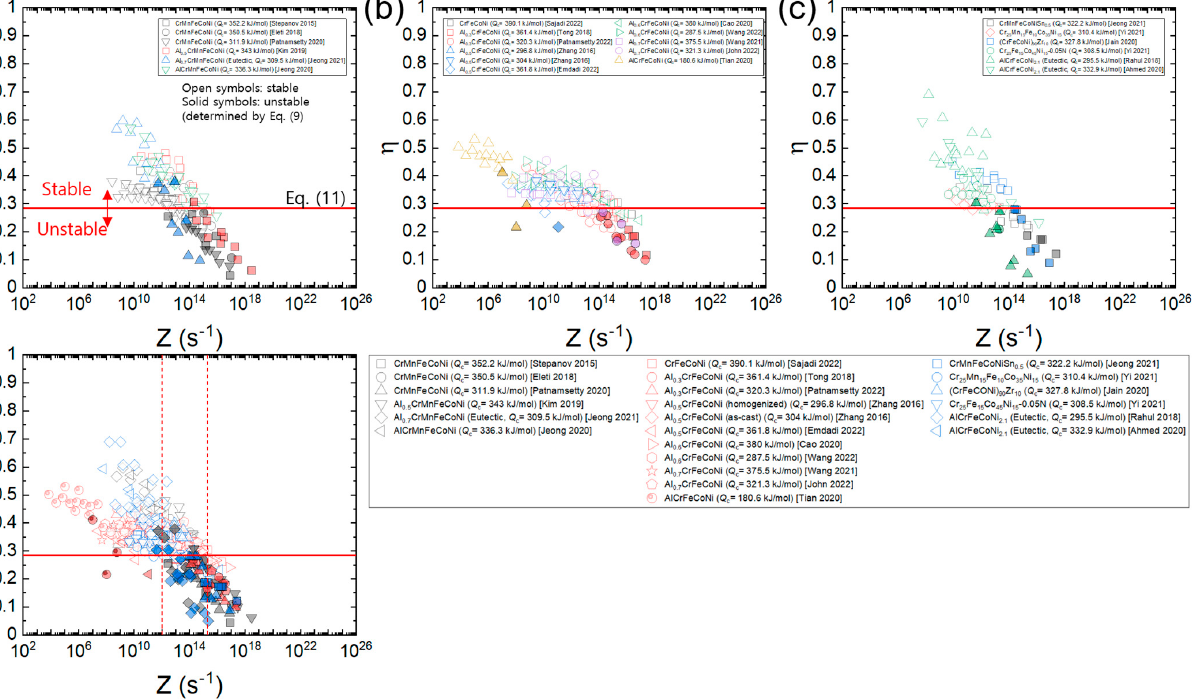
Figure 12. Plots of processing maps for ( a ) Al x CrMnFeCoNi ( x = 0–1) [9,23,34,42,45,63] , ( b ) Al x CrFeCoNi ( x = 0–1) [13,25,51,53,72,84,92,96,97,100] , and ( c ) CrMnFeCoNiSn 0.5 , etc. [22,47,54,60,61,64] , expressed as a function of Z using each Q c value of the HEAs (Table 1) and ( d ) the plot where all the data in ( a – c ) overlap. Open and solid symbols represent the flow stability and instability conditions (determined by Equation (9)), respectively. A red horizontal line represents η = 0.285 (Equation (11)).